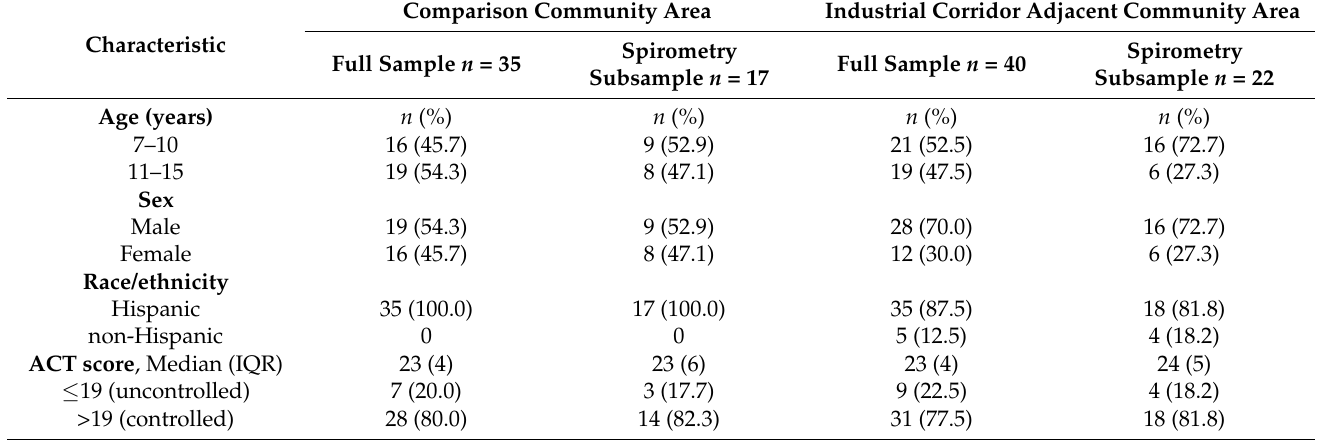
Table 1. Selected characteristics of study participants by community area, comparing the full sample ( n = 75) to those with available spirometry ( n =